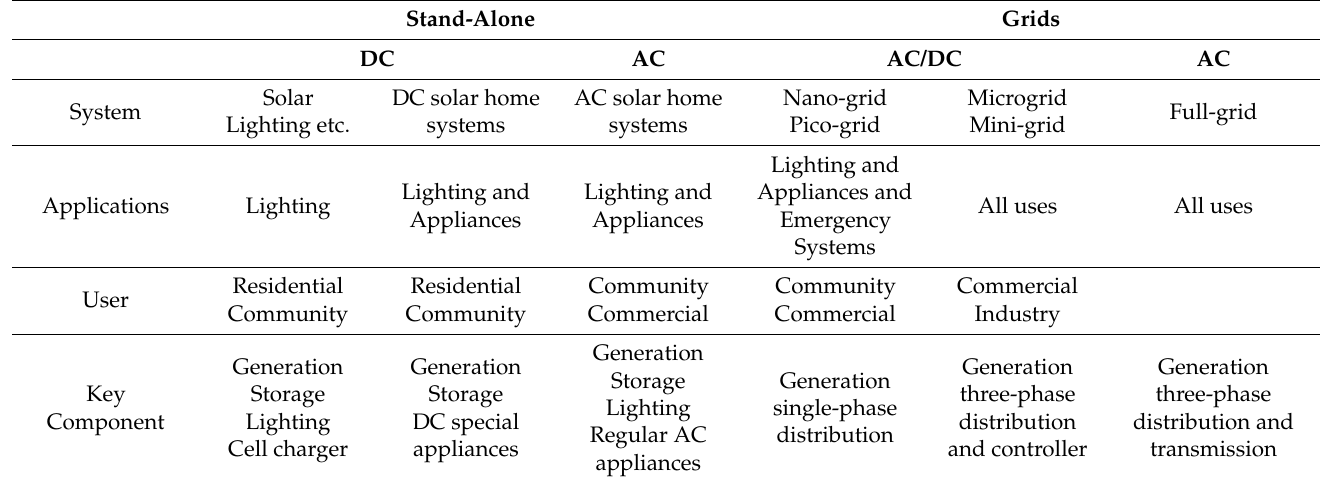
Table 1. Categorization of systems based on applications, users and individual segments [12].